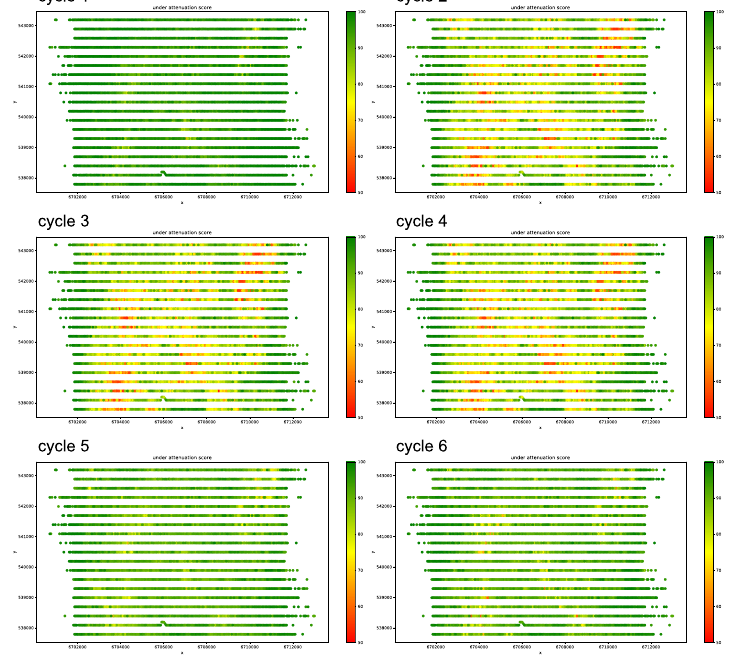
Figure 8. Spatial distribution of over and under attenuation scores through the cycles for